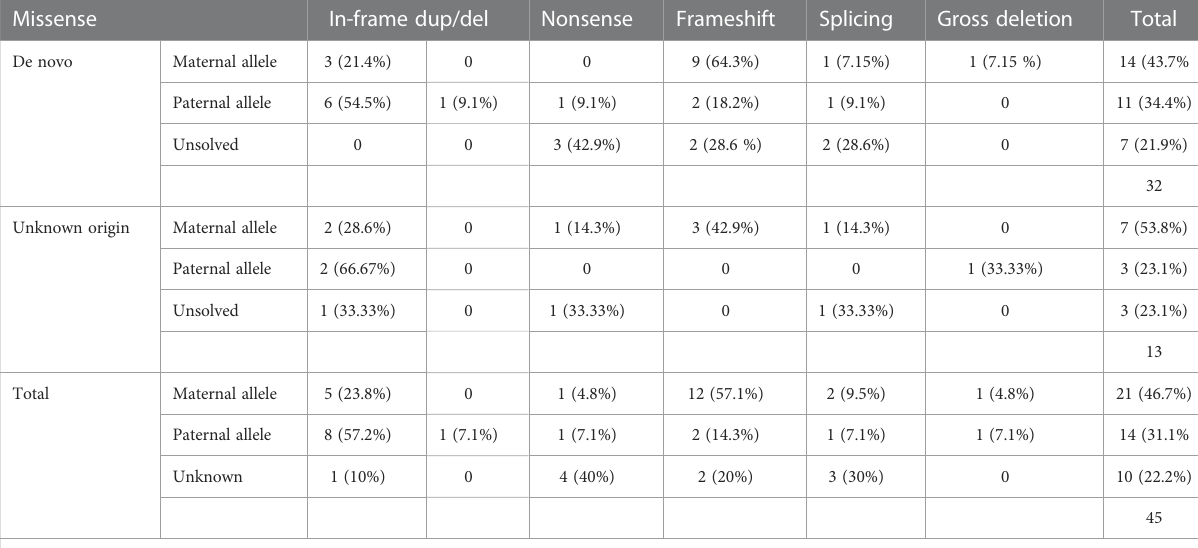
TABLE 2 Description of the type of variants identi fi ed in the GNAS gene and the allele in which they are found in patients of variants of de novo or unknown origin.